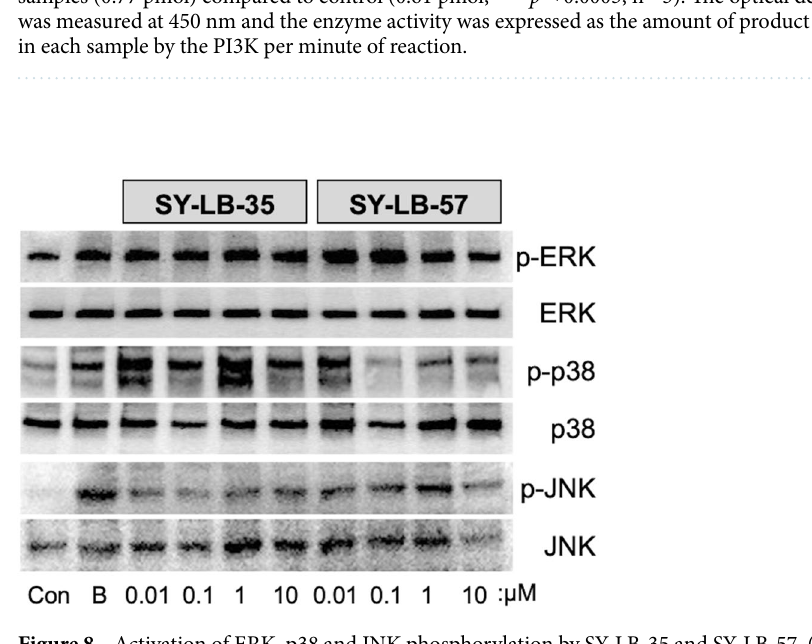
Figure 8. Activation of ERK, p38 and JNK phosphorylation by SY-LB-35 and SY-LB-57. ( A ) Western Blot analysis was performed on whole cell lysates of serum-starved C2C12 cells stimulated by SY-LB-35 or SY-LB-57 (0.01–10 µM) for 15 min. BMP2 (50 ng/mL) served as the positive control. Blots were probed with antibodies against p-ERK, ERK, p-p38, p38, p-JNK and JNK. SY-LB-35 and SY-LB-57 stimulated increases in phosphorylation of all three intracellular signaling targets at all concentrations tested (n = 3). The original, uncropped blots are presented in Supplemental Fig. S8 (ERK blots), S9 (p38 blots) and S10 (JNK